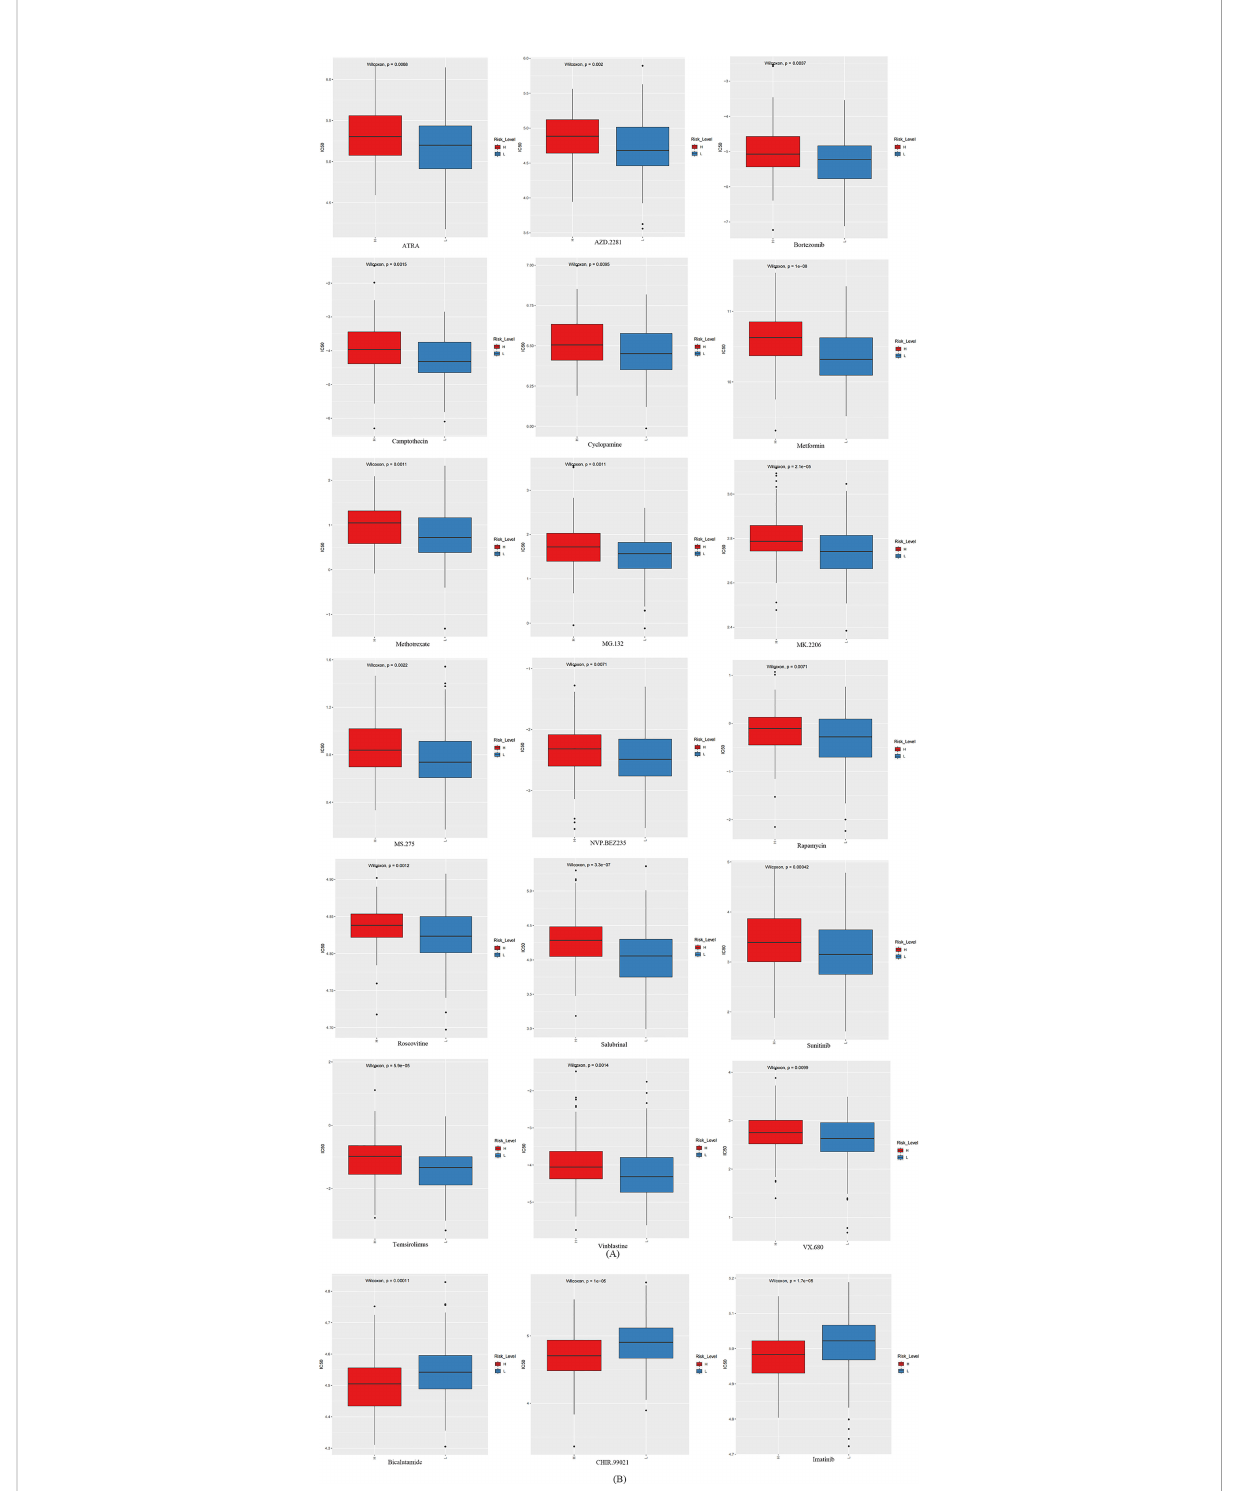
FIGURE 8 The box plots which revealed the IC50 values of 21 therapeutic agents between two groups. (A) The estimated IC50 values of 18 therapeutic agents were higher in the group with higher risk scores. (B) The estimated IC50 values of three therapeutic agents were higher in the group with lower risk